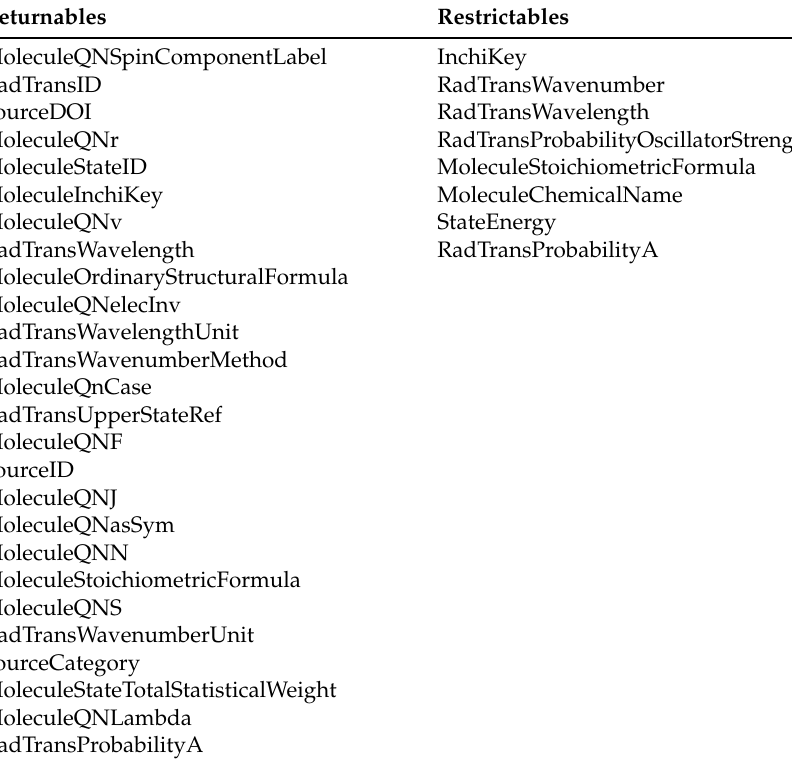
Table A2. SESAM service